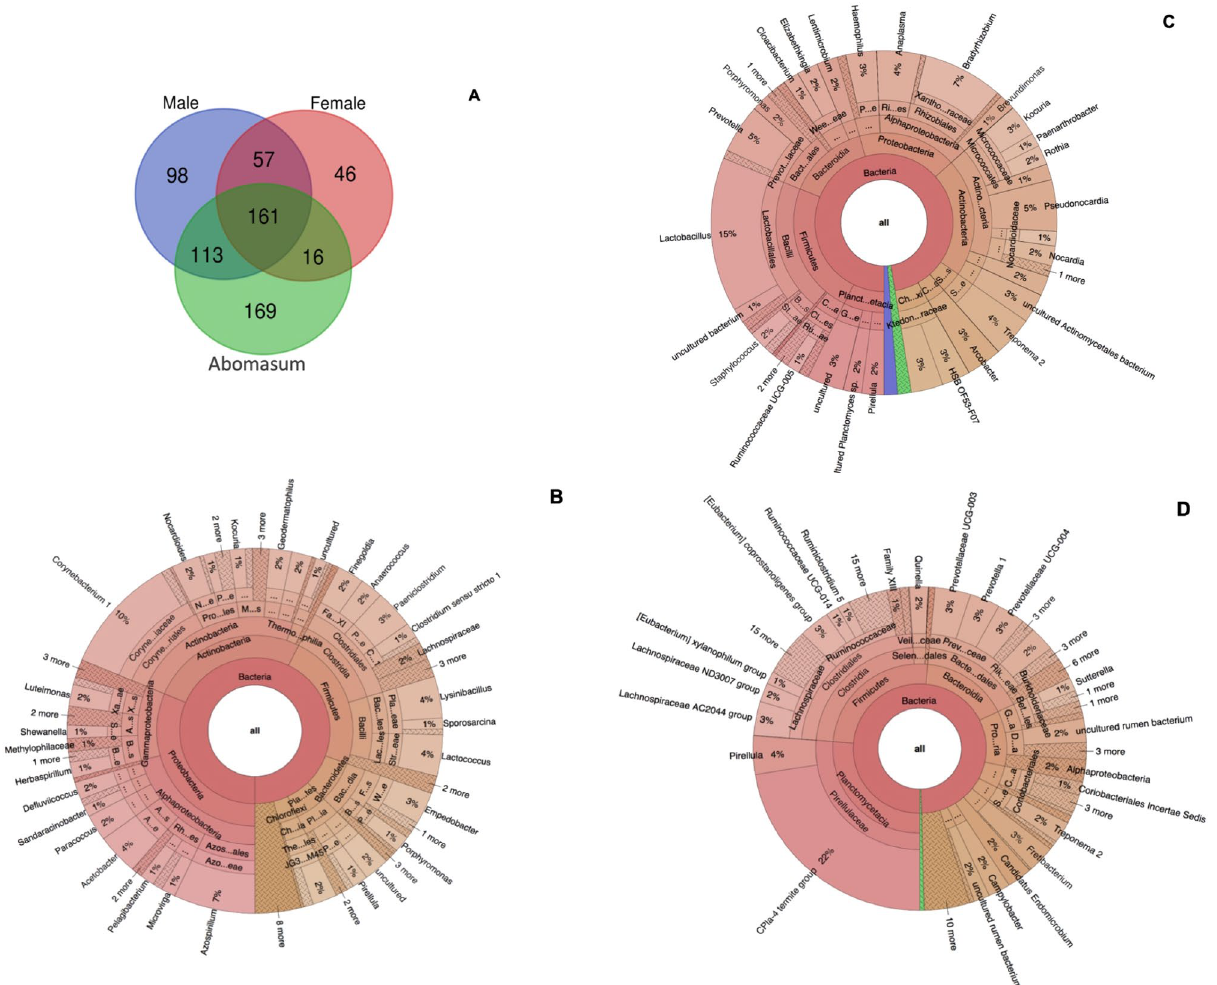
Figure 4. Venn diagram ( A ) and krona plot depicting the composition and number of unique and shared OTUs associated with adult male ( B ), female ( C ) H. contortus and abomasum content ( D ) microbiome. Data represent average values from pooled